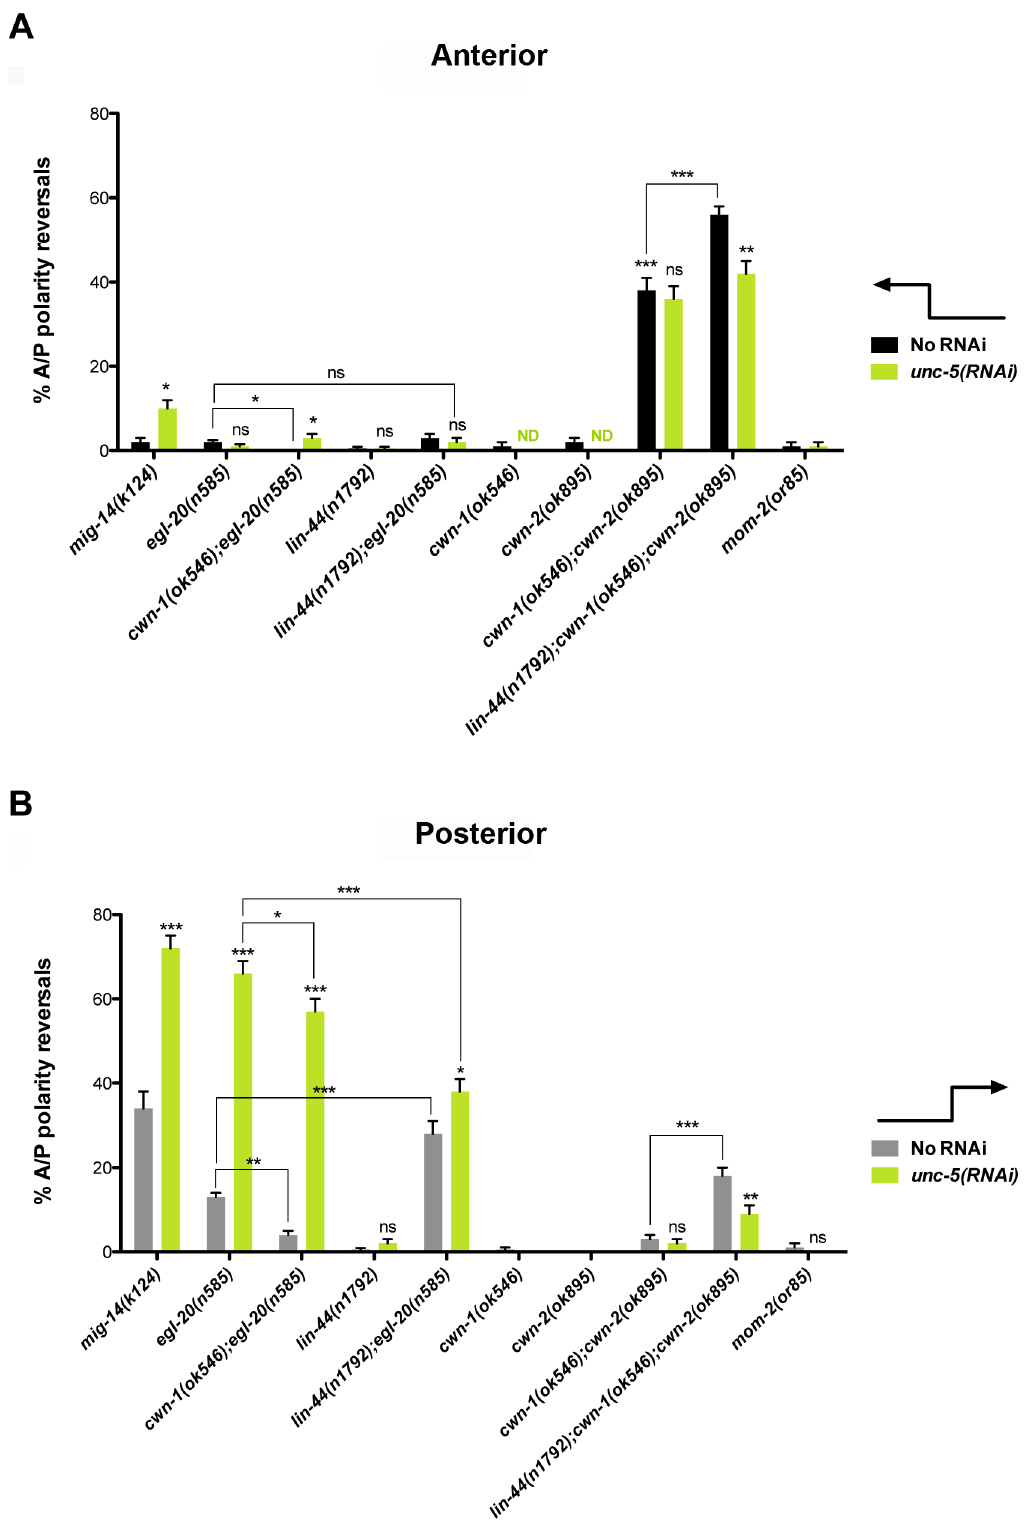
Figure 5. UNC-5 and Wnt ligands function redundantly or in mutual opposition to determine A/P polarity. (A) Shown is the frequency of anterior DTCs exhibiting phase 3 A/P polarity reversals in wnt mutants not treated (black bars) or treated (green bars) with unc-5 RNAi. (B) Shown is the frequency of posterior DTC phase 3 A/P polarity reversals in Wnt receptor mutants not treated (grey bars) or treated (green bars) with unc-5 RNAi (green bars). The corresponding raw data are presented in Table S5. Error bars indicate standard error of the sample proportion. Comparisons of A/P polarity reversals in multiple mutant lines were made to the corresponding single and double mutant controls or as indicated by the connecting lines. ***P , 0.00001 **P , 0.001; *P , 0.05; ns=not significant. doi:10.1371/journal.pgen.1004381.g005 PLOS Genetics |